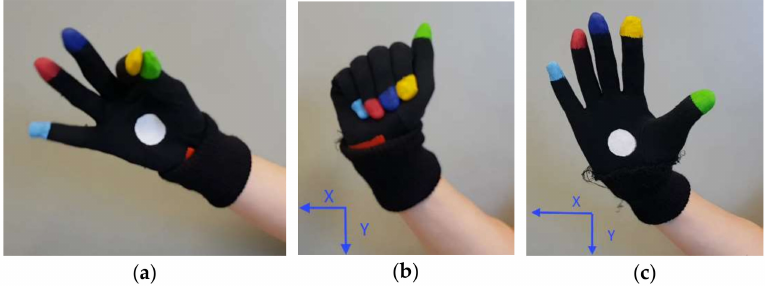
Figure 7. Hand pose without reflective markers during ( a ) FT, ( b ) OC, and ( c ) PS. For OC and PS the reference directions for the components of the movements are